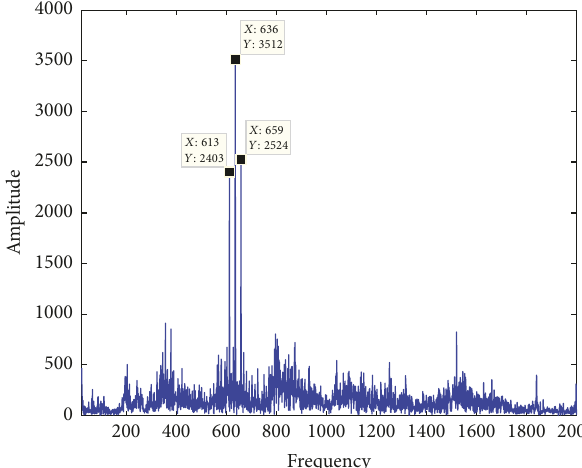
Figure 15: The LCT of the selected signal segment from the fault gear.